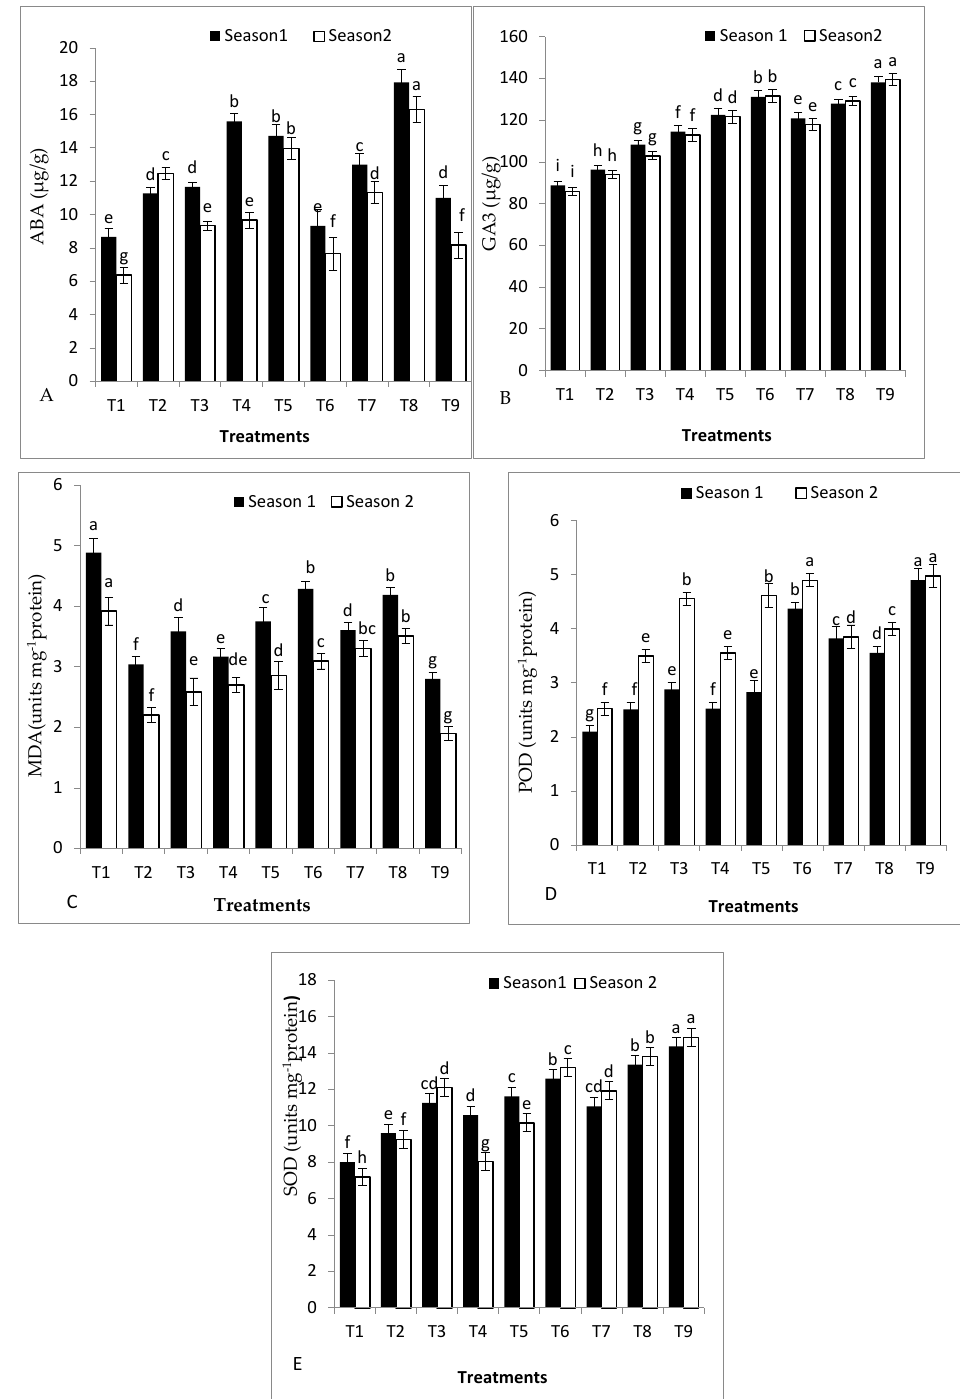
Figure 4. Effects of grafting, rootstock seed treated with SA, and colonisation with S. griseus on ( A ) GA3 , ( B ) ABA , ( C ) MDA , ( D ) POD, and ( E ) SOD in the first and second seasons. Treatments: T1—self-grafted Peto 86/Peto 86 (control); T2— Peto 86/ S. cheesmaniae ; T3—Peto 86/GS hybrid; T4—Peto 86/Peto 86 + SA; T5—Peto 86/ S. cheesmaniae + SA; T6—Peto 86/GS hybrid + SA; T7—Peto 86/Peto 86 + S. griseus; T8—Peto 86/ S. cheesmaniae + S . griseus; and T9—Peto 86/GS hybrid + S. griseus. Standard errors of the mean are shown as vertical bars; the LSD test indicates that differences between values in each bar that are marked by different letters are significant at p = 0.05.